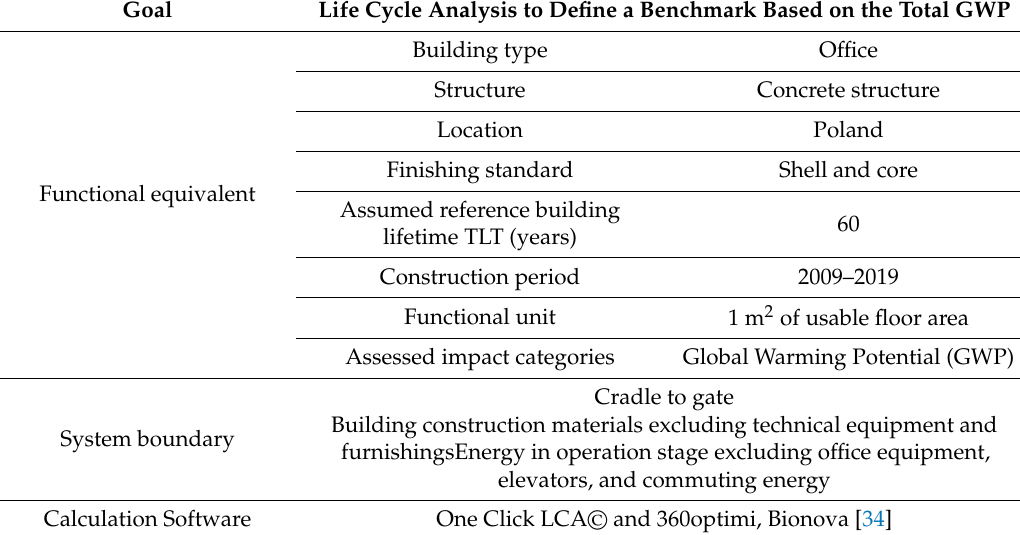
Table 2. Summary of the goal and scope